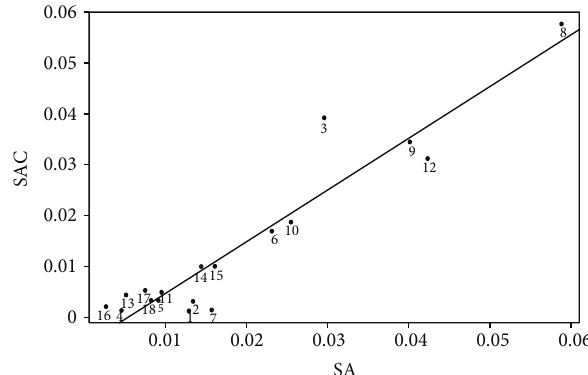
Figure 5: Linear regression plot of relative peak areas between Syzygium aromaticum (SA) and Syzygium aromaticum combined with Curcuma aromatica (SAC) except for outliers (gallic acid, ellagic acid, and eugenol). Peak 1–18: unidentified compounds. Table 5: Regression analysis of the relative peak areas between Syzygium aromaticum (SA) and Syzygium aromaticum combined with Curcuma aromatica